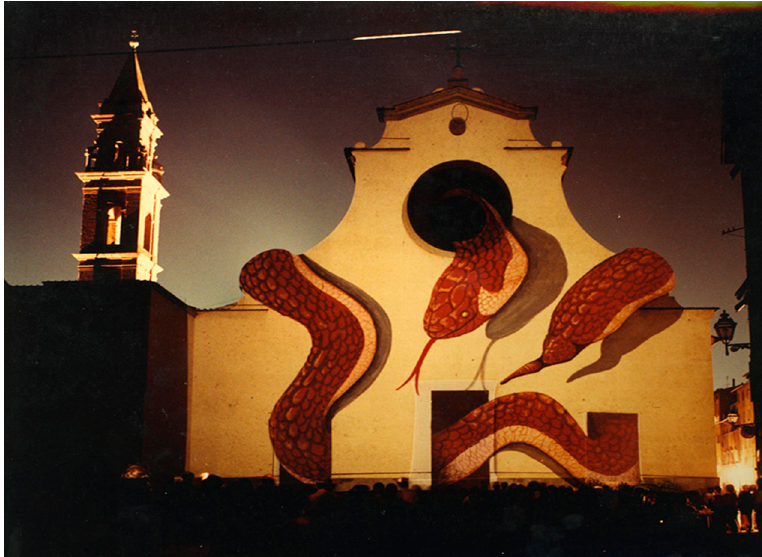
Figure 3. Florence 1980. One of the various slides projected by Mario Mariotti over the façade of Santo Spirito Church. The project, called Piazza della Palla, has involved many artists and common florentines, that created evocative finishing hypothesis of Brunelleschi uncompleted